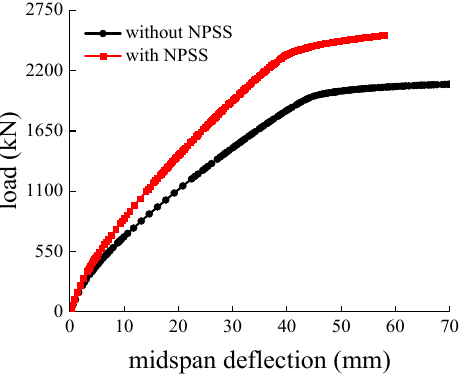
Figure 18. The midspan deflection-load curves for the cases of with and without NPSS.